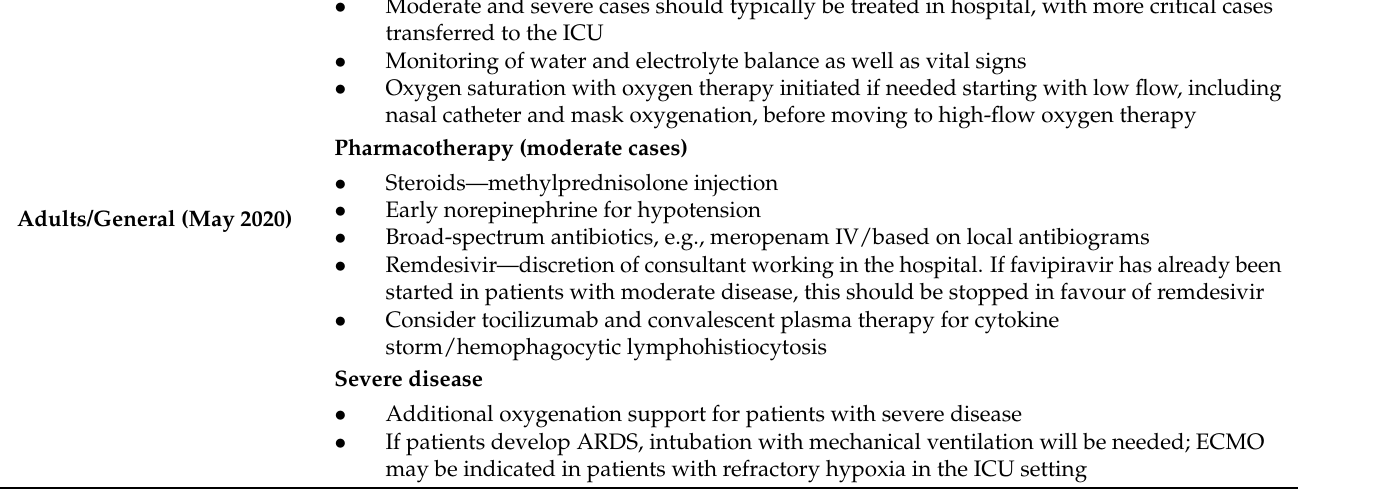
Table 1. Key recommendations for managing adults and children with COVID-19 in hospitals in Bangladesh (adapted from